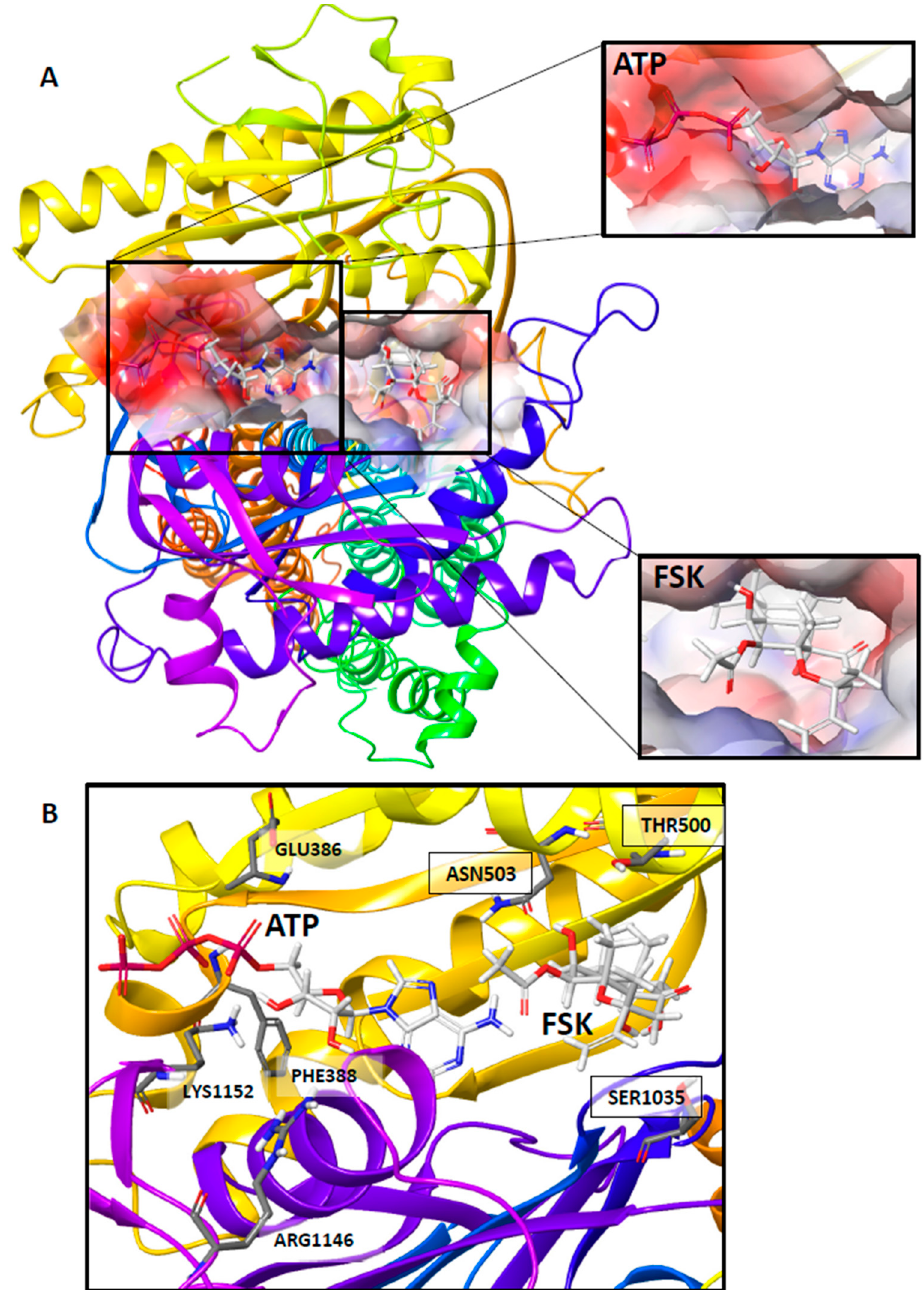
Figure 2. Molecular model of human adenylyl cyclase isoform 6 bound to adenosine triphosphate (ATP) and Forskolin (FSK). The homology model of human AC6 was built using Schrodinger Maestro v12.2, including catalytic domain C 1 , and domain C 2 with transmembrane helix (TM). ( A ) FSK (lower subimage) and ATP (upper subimage) are bound in the interface between AC6-C1 and AC6-C2. The blown-out image of the binding site surface shows the docked ATP at the catalytic site (upper callout) Glutamate (GLU386), Phenylalanine (PHE388), Arginine (ARG1146), and Lysine (LYS1152)